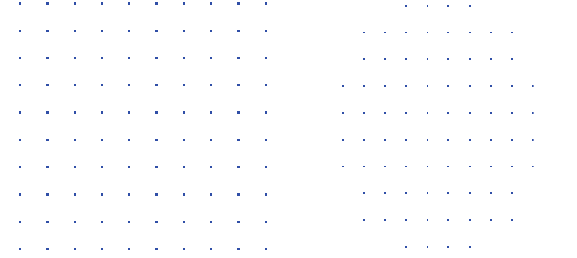
Figure 5: SPH model of a single 2.75 kg large bird. Table 4: Parameters of hydrodynamic elastic-plastic